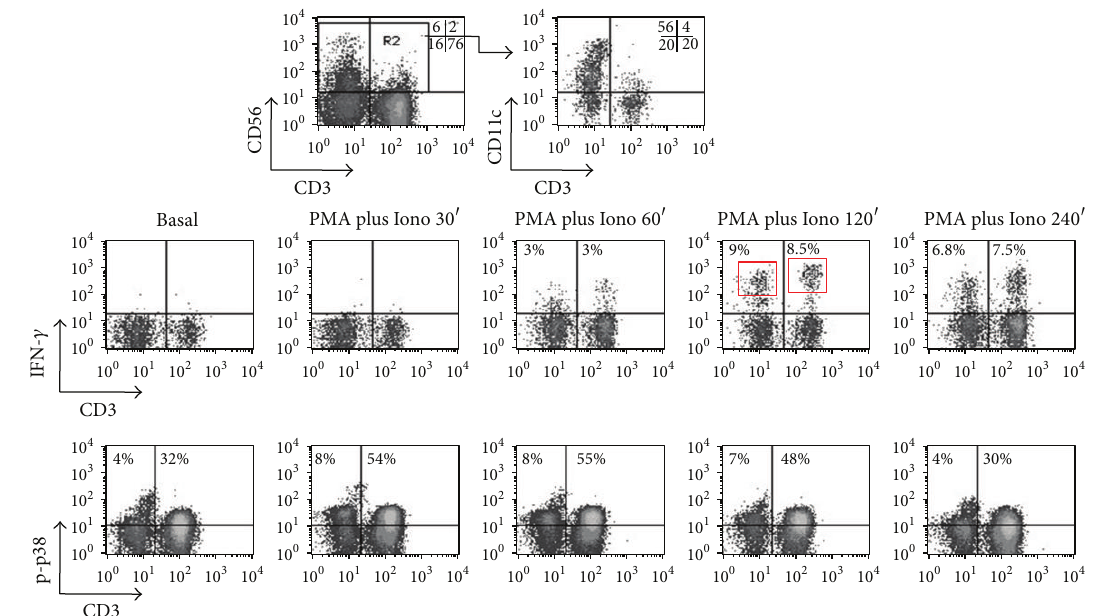
Figure 5: Optimal cytokine expression and p-p38 detection within PBMCs subsets permeabilized with methanol. PBMCs were stimulated with PMA plus Ionomyci at various time points, permeabilized in methanol, and stained with MoAbs against CD3, CD56, CD11c, p-p38, and IFN- 𝛾 . CD56+ cells were subgated and the percentage of CD11c+ within CD56+ cells is indicated. Gated CD56+ cells were plotted for CD3 versus IFN- 𝛾 and CD3 versus p-p38. As it can be seen, IFN- 𝛾 expression is detectable between 60 󸀠 and 240 󸀠 , reaching its peak at 120 󸀠 , while maximal p-p38 activity is better visualized at 30 󸀠 . NKT cells express more IFN- 𝛾 than NK as indicated by the measured percentages and mean fluorescence intensity of IFN- 𝛾 + NKT cells (see text for more